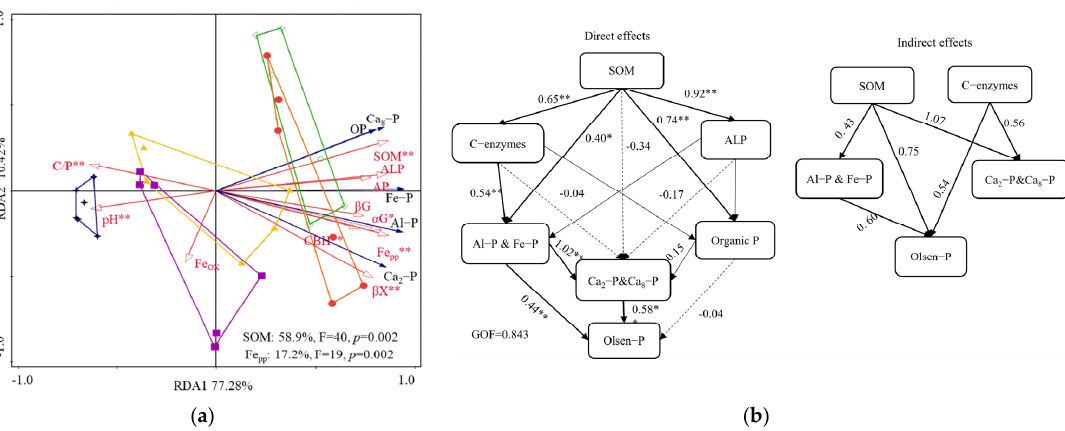
Figure 4. Redundancy analysis plots of the correlations between the soil properties and the phos- phorus fractions ( a ); the partial least squares path model (PLS − PM) of the direct and indirect e ff ects among the soil SOM, C recycling enzymes, alkaline phosphatase, P fractions and Olsen − P ( b ). The observed variables are shown in the solid boxes. The numbers next to the single − headed arrows are the standardized path coe ffi cients. The black solid and dashed line arrows represent positive and negative correlations, respectively. The goodness of fi t (GOF) value is calculated to evaluate the model. “*” indicates p < 0.05 and “**” indicates p < 0.01.